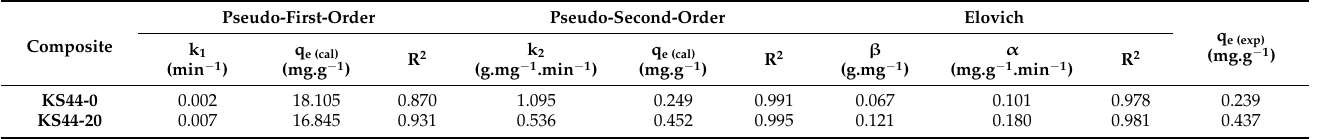
Table 2. Kinetic parameters for RhB dye adsorption on KS44-0 and KS44-20: (C 0 = 10 mg.L − 1 , pH = 3 and T = 20 ◦